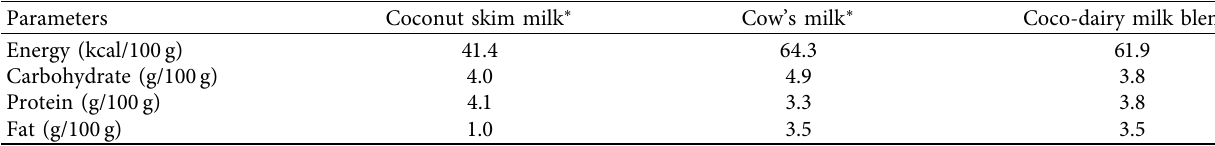
Table 1: Comparative nutrient analyses of milk products.